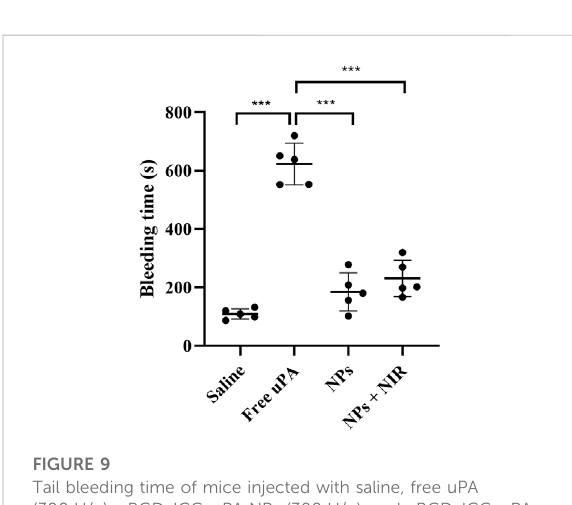
FIGURE 9 Tail bleeding time of mice injected with saline, free uPA (300 U/g), cRGD-ICG-uPA NPs (300 U/g), and cRGD-ICG-uPA NPs with NIR laser irradiation (300 U/g; 0.3 W/cm 2 ) ( n = 5). Data were represented as mean ± SD ***p <